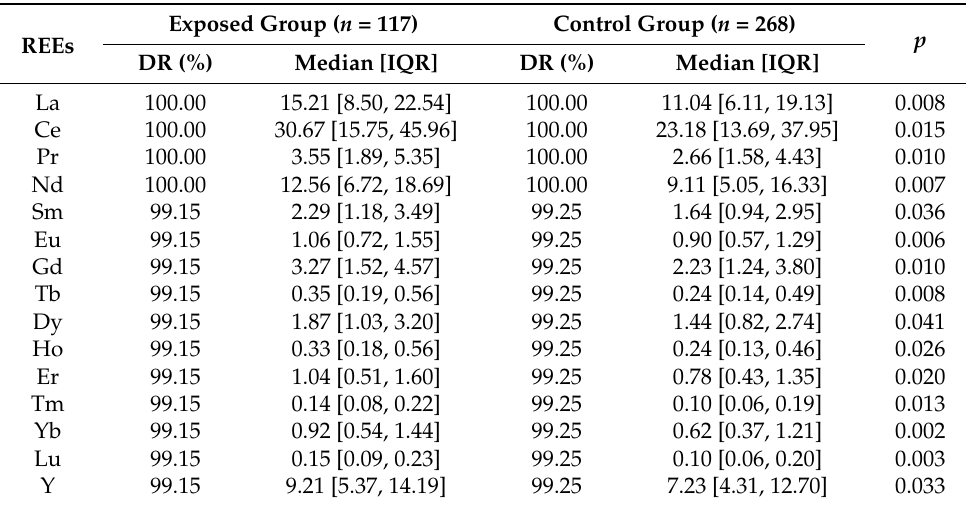
Table 2. Concentrations (ng/g hair) of the fifteen rare earth elements (REEs) in the exposed group and control group.